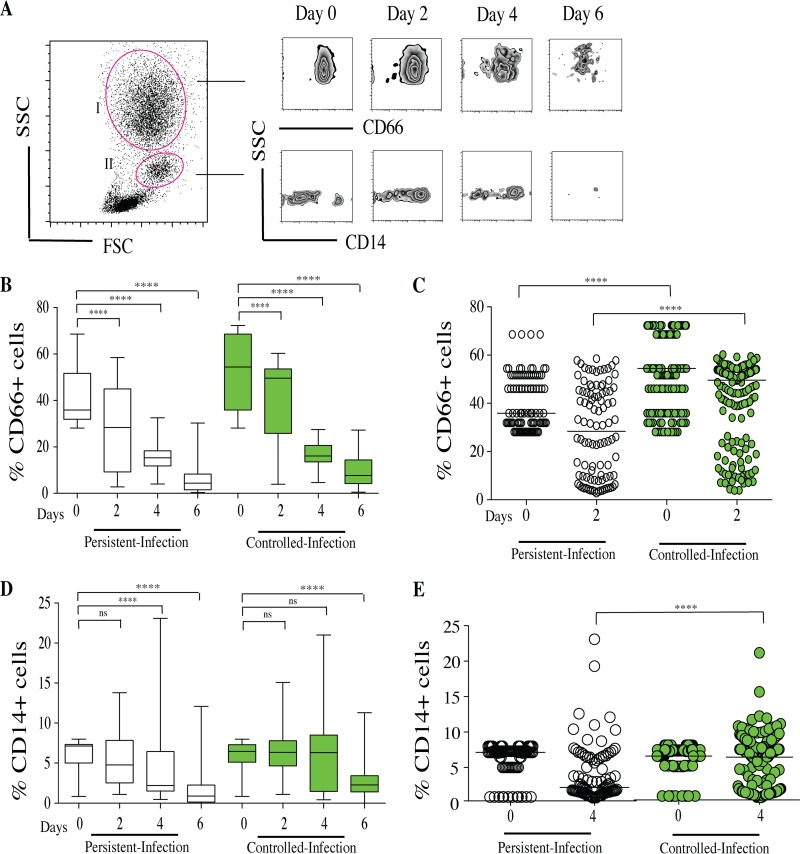
Characterization of CD66+ and CD14+ cell proportions within Candida granuloma-like structures over time. Peripheral blood mononuclear and polymorphonuclear cells from 10 healthy subjects were infected with 32 Candida clinical isolates for up to 6 days. The granuloma-like structures were collected from coculture plates at different time points and stained with a cocktail of fluorescence-conjugated antibodies specific to CD66 neutrophils and CD14 monocytes. (A) Representative flow cytometry analysis showing a side-scatter (SSC) versus forward-scatter (FSC) plot of granulocyte (I) and monocyte (II) selection. CD66+ cells were gated from region I, and CD14+ monocytes were gated from region II. (B) The proportions of CD66+ cells within granuloma-like structures are expressed as percentages of the total living cell compartment. Box plots depict median, minimum, and maximum percentages of CD66+ cells in persistent-infection and controlled-infection subjects. (C) Scatter plot of CD66+ proportions according to persistent-infection and controlled-infection status. (D) The proportions of CD14+ cells within granuloma-like structures are expressed as a percentage of the total living cell compartment. Box plots depict median, minimum, and maximum percentages of CD14+ cells according to persistent-infection and controlled-infection status. (E) Scatter plot of CD14+ cells proportions. *, P < 0.05; **, P < 0.001; ***, P < 0.0001; ****, P < 0.00001 (by one-way ANOVA with Tukey's multiple-comparison test) (n = 320). ns, not significant.